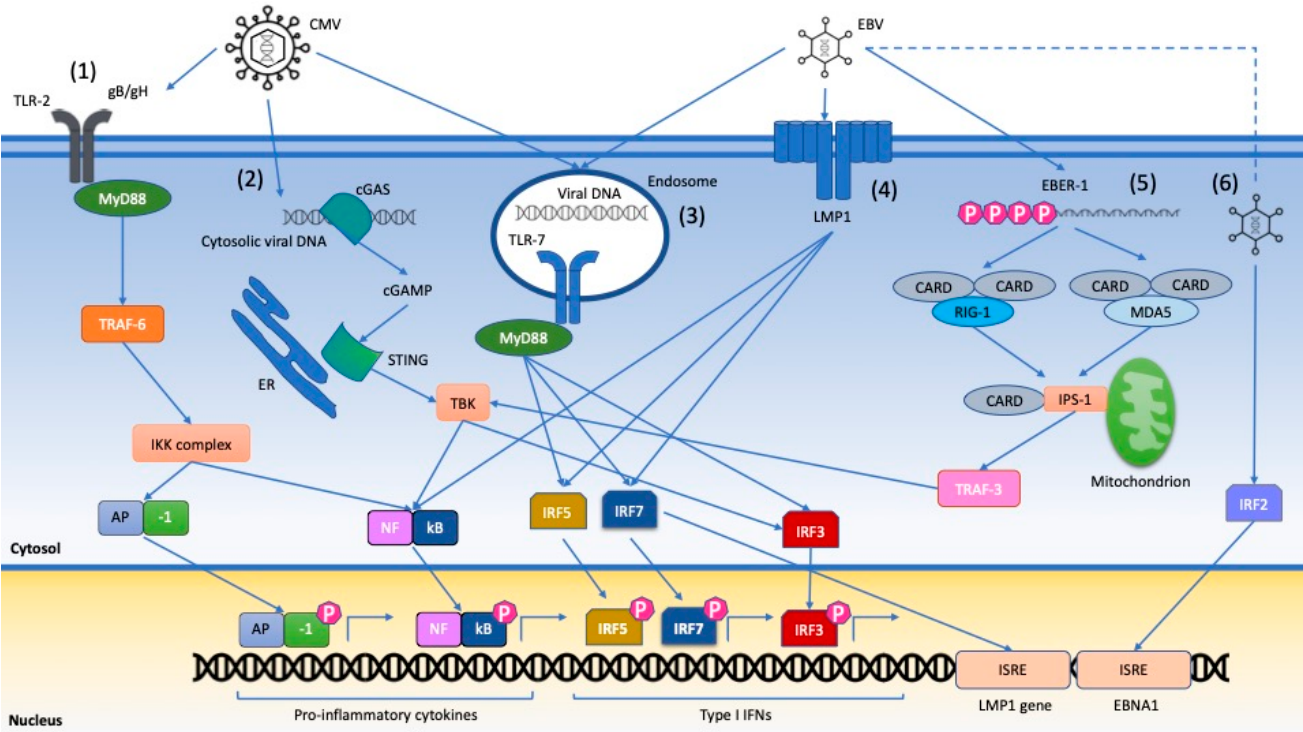
Figure 1. Multiple intracellular pathways triggered by Cytomegalovirus (CMV) and Epstein–Barr virus (EBV) infection converge on expression of proinflammatory cytokines and type I Interferon (IFN) response genes. (1) CMV glycoproteins B and H (gB/gH) engage surface TLR-2 and trigger an inflammatory pathway leading to AP-1 activation; (2) cytosolic CMV-DNA interacts with cyclic GMP-AMP synthase (cGAS) and initiates a cascade that targets NFkB and IRF3; (3) CMV nuclear material trafficked to the endosome triggers TLR-7 signaling, leading to IRF-3, -5 and -7 activation; (4) in EBV latency phase, LMP1 induces expression of IR-5, -7 and NFkB; (5) cytosolic EBER-1 is recognised by RIG-1 and MDA-5 and associates with IPS-1 via CARD-like domains, leading to NFkB and IRF3 activation; (6) EBV induces IRF2 and activates ISRE, which codes for EBNA proteins. Legend: MyD88: Myeloid differentiation primary response 88, IKK complex: IkB kinase complex, TRAF: TNF receptor associated factor, AP-1: activator protein-1, EBER-1: EBV-encoded RNA-1; ER: endoplasmic reticulum, cGAS: cyclic GMP-AMP synthase, cGAMP: cyclic guanosine monophosphate-adenosine monophosphate, STING: cyclic GMP-AMP receptor stimulator of interferon genes, TBK: TANK-binding kinase, IRF: interferon regulator factor, LMP1: Epstein–Barr virus latent membrane protein 1, RIG-1: retinoic acid-inducible gene 1, CARD: caspase activation and recruitment domain, MDA5: melanoma differentiation-associated protein-5, IPS-1: interferon-beta promoter stimulator 1, ISRE: IFN-stimulated response